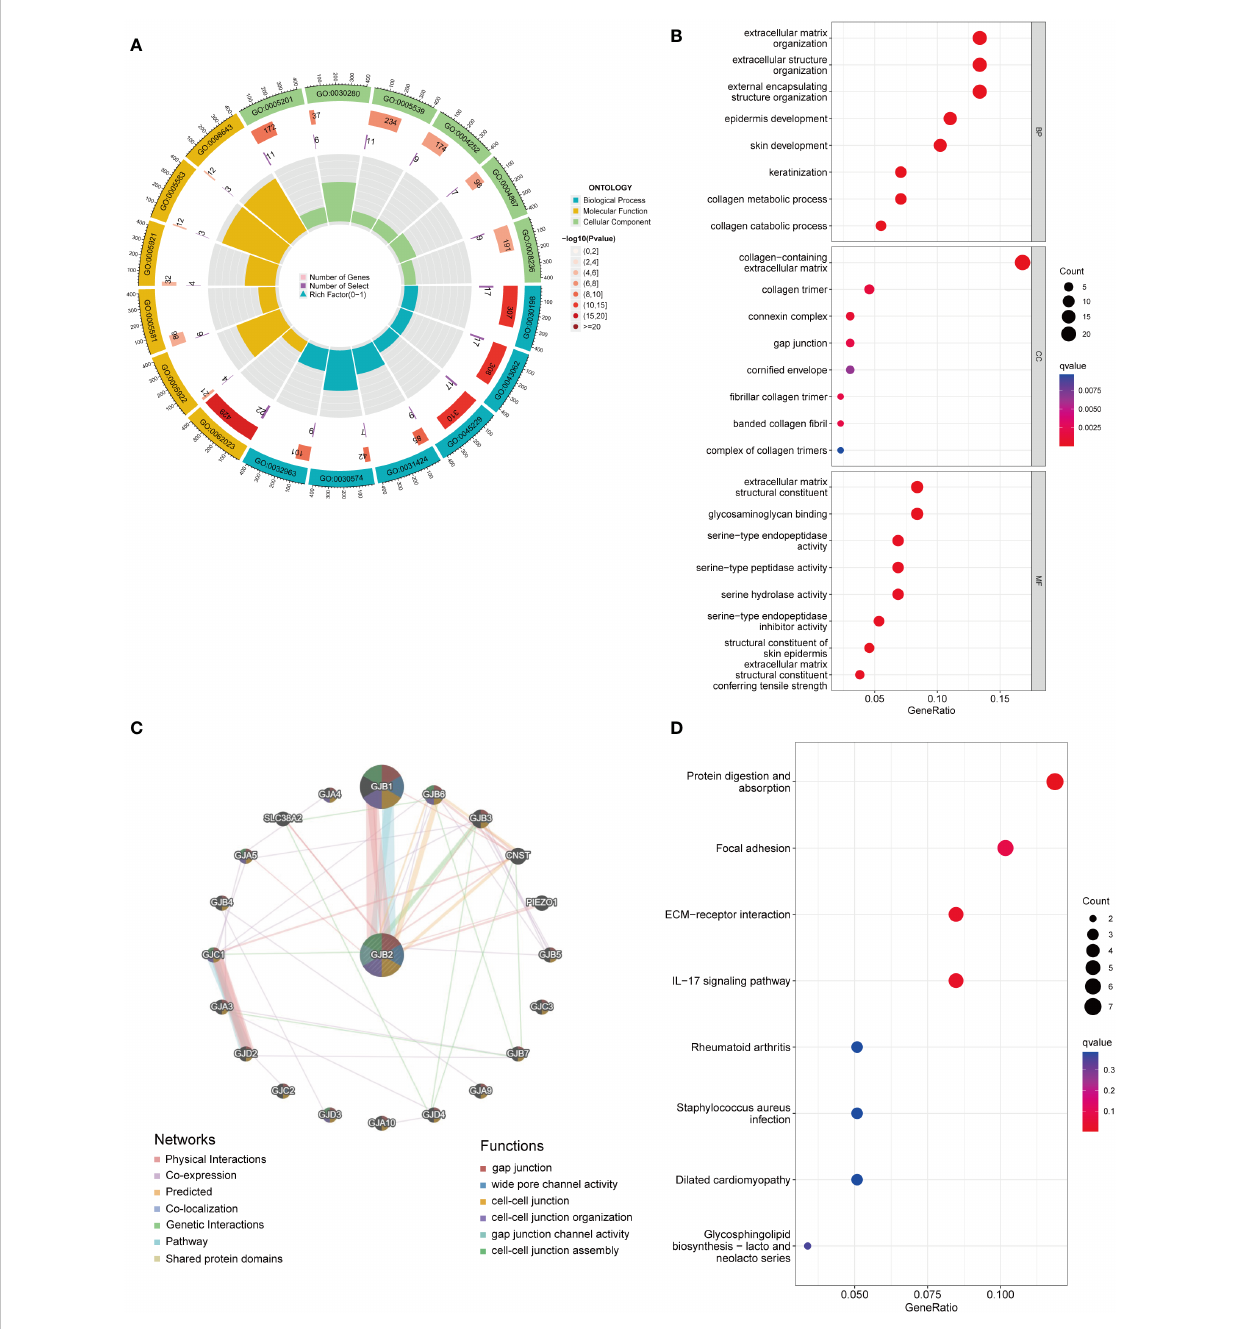
(Figure 8B). We then fully evaluated the signi fi cantly different expression for the mean RNA expression of GJB2 -related DEGs in the LUAD samples by using the AverageExpression function of Seurat. And the mean RNA expression of the hub-genes in cytoscape networks was shown by violin plot and scatter plot with signi fi cantly different percentages of major cell types. But due to sample reasons, the expression of MMP3 and SPRR1A in the hub-genes was not detected in the dataset (Supplementary Figure